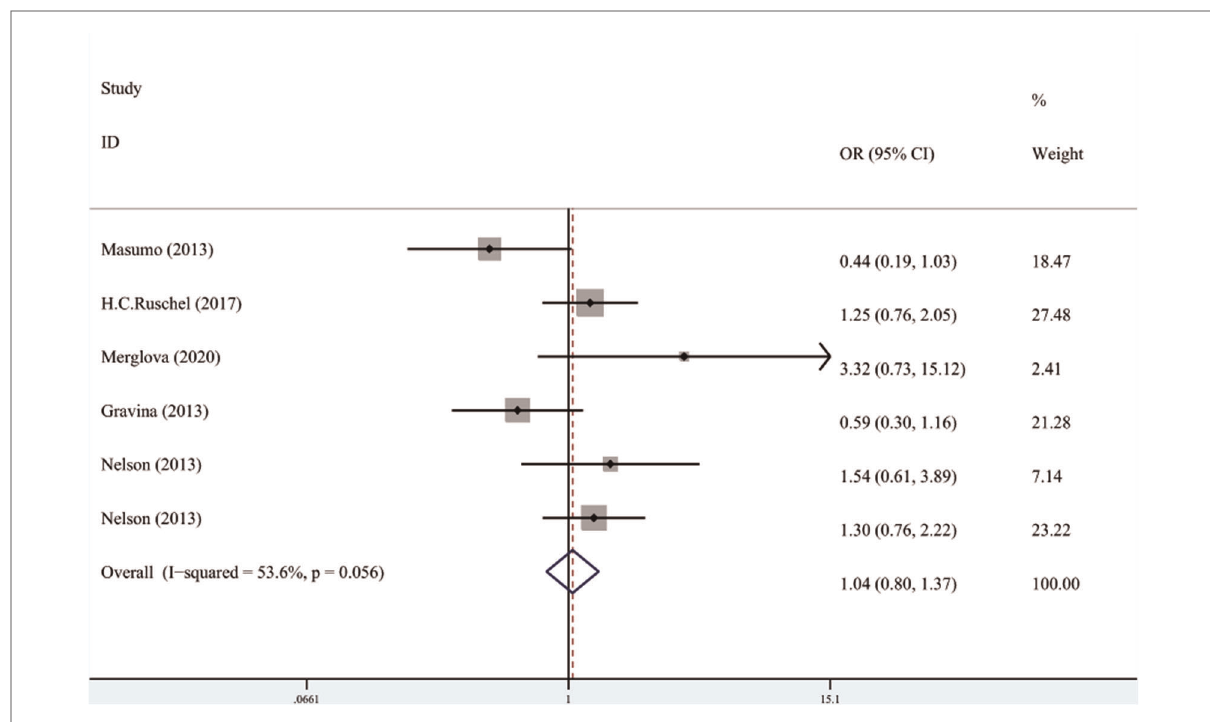
FIGURE 8 The forest plot shows the relationship between LBW and enamel opacity (REM). LBW, low birth